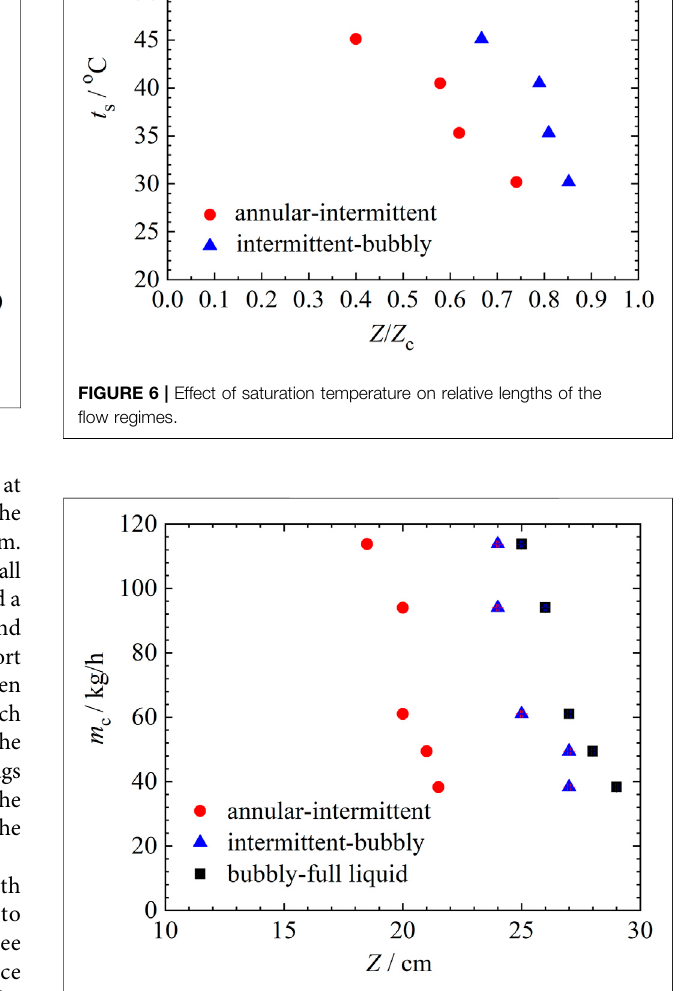
FIGURE 7 | Effect of the cooling water mass fl ow rate on fl ow regime